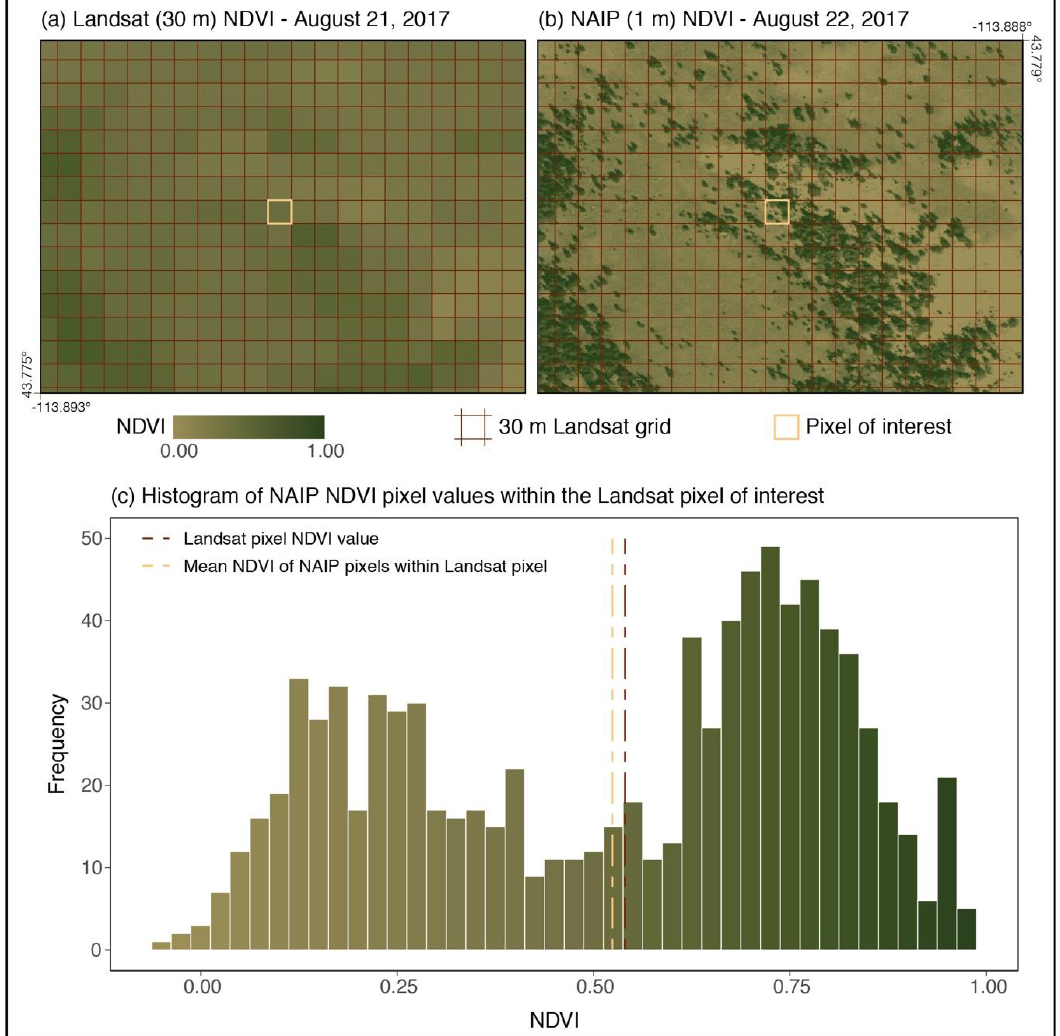
Figure 1. Example demonstrating sub-pixel variability of 30 m normalized difference vegetation index (NDVI) derived from Landsat ( a ) and 1 m National Agriculture Imagery Program (NAIP) NDVI ( b ); the distribution of NAIP NDVI values within the Landsat pixel of interest ( c ).